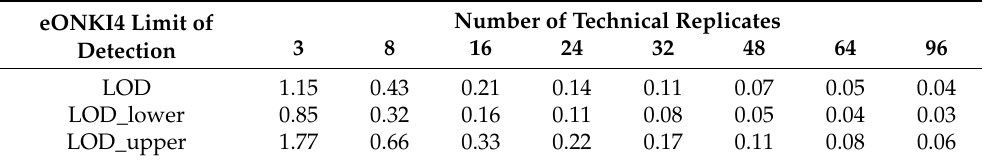
Table 3. Assay limits of detection (LOD) in copies per reaction and their lower and upper confidence limits for various numbers of technical replicates for the eONKI4 coho salmon assay in a controlled lab setting. The LOB for the assay was zero.